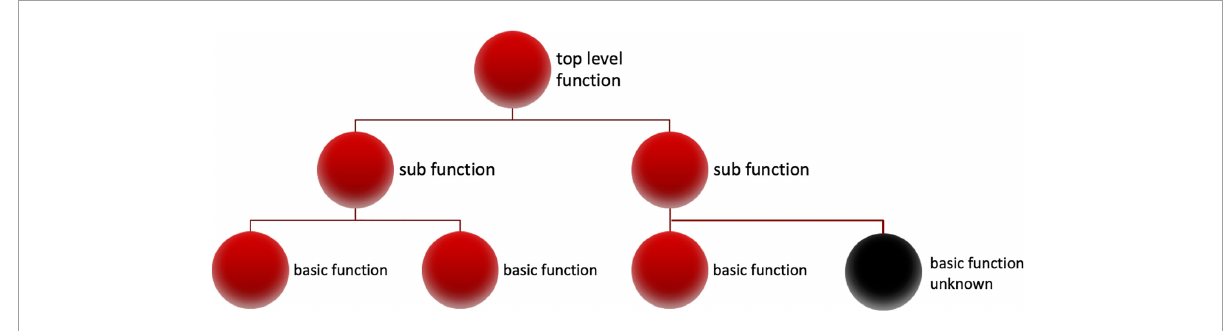
FIGURE1 Reverse engineering is expressed schematically as performance of a functional analysis (Cummins, 1975, Cummins, 2000). The top level function of the whole system is decomposed into sub-functions, which can themselves be explained in terms of the interaction of basic functions. See also Bechtel and Richardson (2010) on the research strategy of functional decomposition, employed for investigating modular, hierarchical